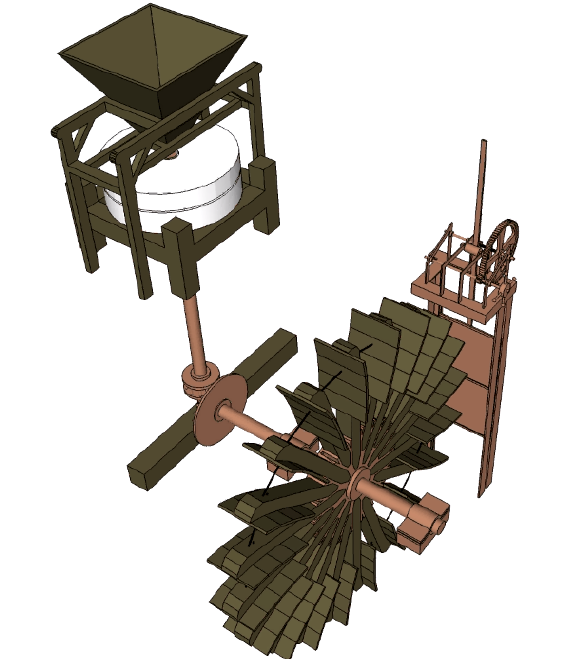
Figure 10: The grinding mechanism isolated from the mill for